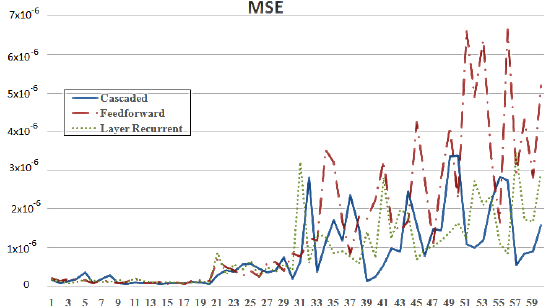
Figure 3. MSE achieved by a benchmark work for three ANN architectures. Reprinted from [10] with